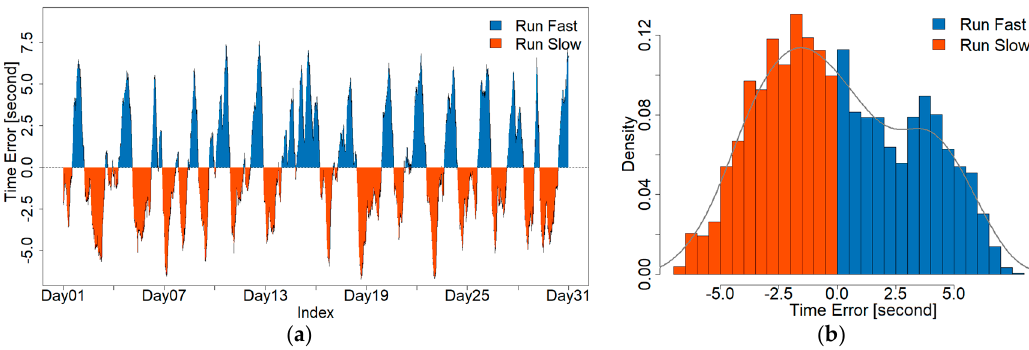
Figure 10. Time error change over one month in Karuizawa, Janpa. ( a ) Time-series curve of time error in October 2016; ( b ) Probabilistic distribution function of time error in one month. The blue color presents the fast time error. The orange color indicates the slow time error. The grey line shows the estimated probability density of time error.